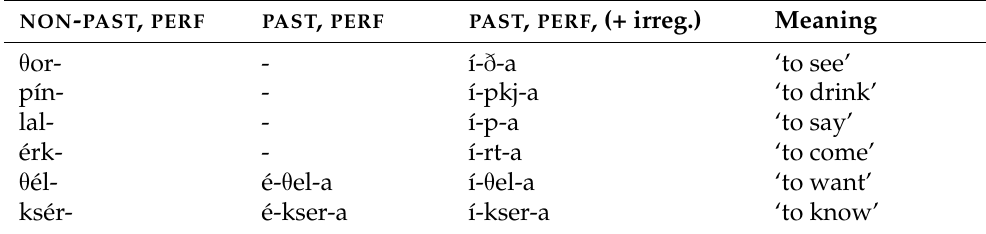
Table 6. Verbs with the irregular augment i-